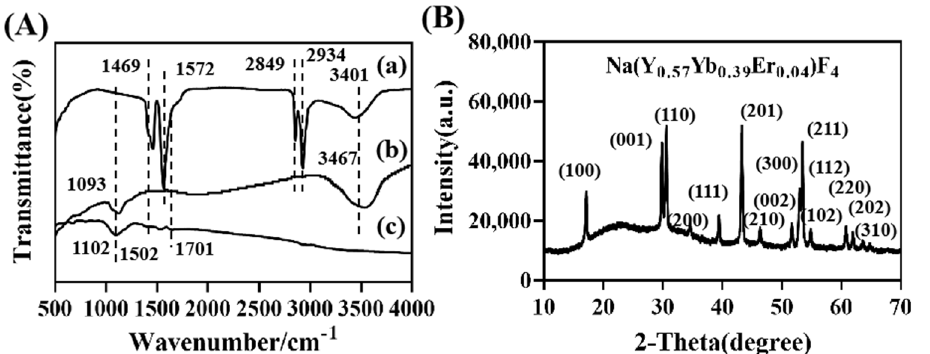
Figure 2. FTIR spectra of OA − UCNPs (a), ADA − UCNPs (b), UCNPs − COOH (c) ( A ); XRD patterns of UCNPs ( B ).